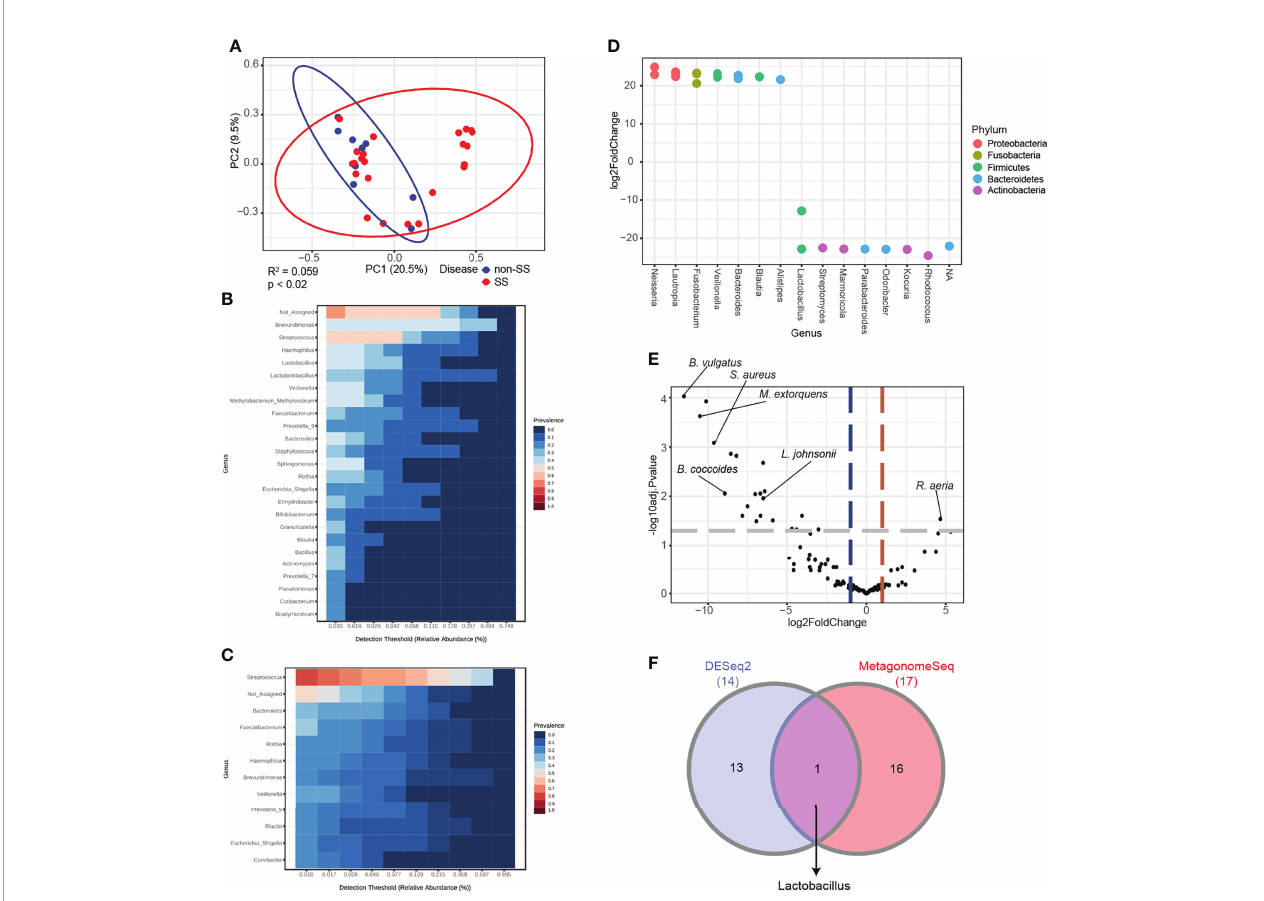
FIGURE 4 | Differential analysis revealed that Lactobacillus is a potential biomarker for Sjögren ’ s syndrome (SS). (A) Principal coordinate analysis of saliva samples from non-SS and SS subjects based on the Bray-Curtis distance method ( n = 32). Eclipses represent 95% con fi dence interval. (B) Core microbiome analysis of saliva from non-SS subjects at the genus level. (C) Core microbiome analysis of saliva from SS subjects at the genus level. (D) DESeq2-driven differential features of the microbiome at the genus level. Positive values of log2 fold change indicate increased abundance in SS subjects. (E) Volcano plot showing differential ASVs derived from metagenomeSeq among SS and non-SS subjects. Gray dashed line indicates p-value cutoff ( p = 0.05). Red and blue dashed lines indicate fold change cutoff (fold change = 2). (F) Intersection of data from DESeq2 and metagenomeSeq was illustrated in the Venn